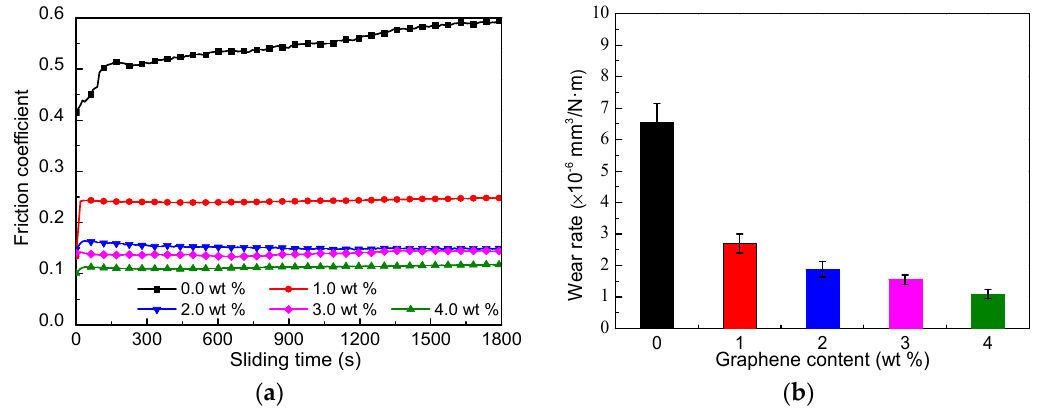
Figure 5. Tribology properties of polymer composite coatings: ( a ) friction coefficient and ( b ) wear rate.